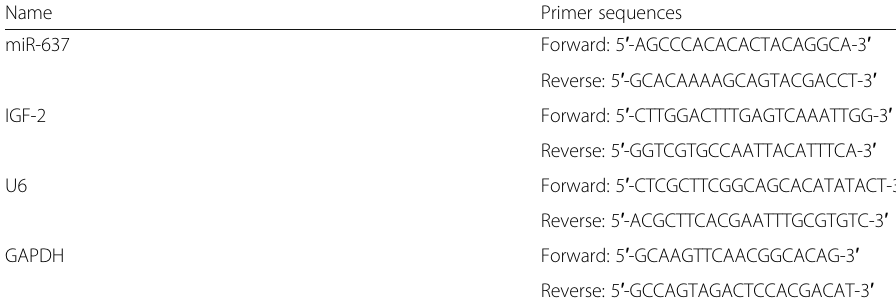
Table 1 Primer sequences for real-time